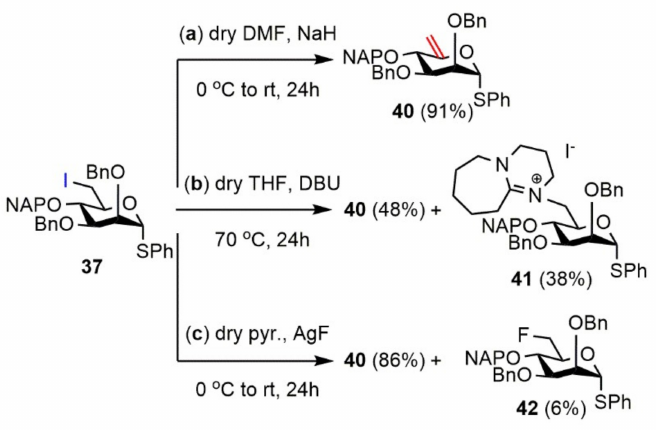
Scheme 4. Elimination reactions of the fully ether-protected D - manno derivative 37